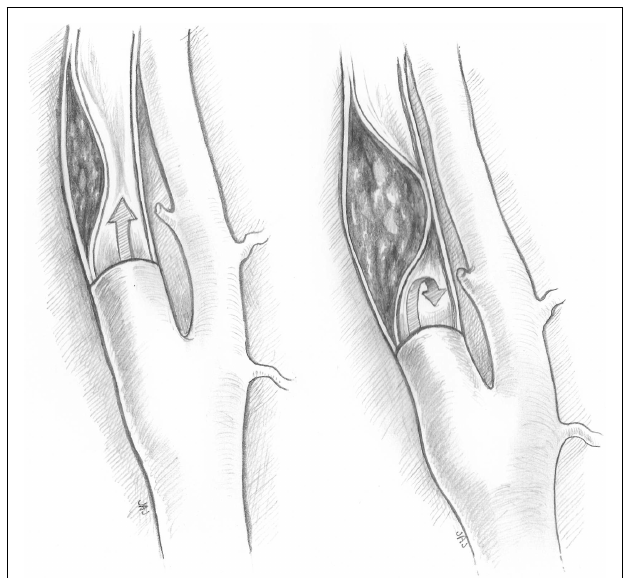
FIGURE 1 |Type IA and type IB dissections .Type I dissections show an intact intima.Type IA (left) has persistent antegrade flow.Type IB (right) is completely occluded.